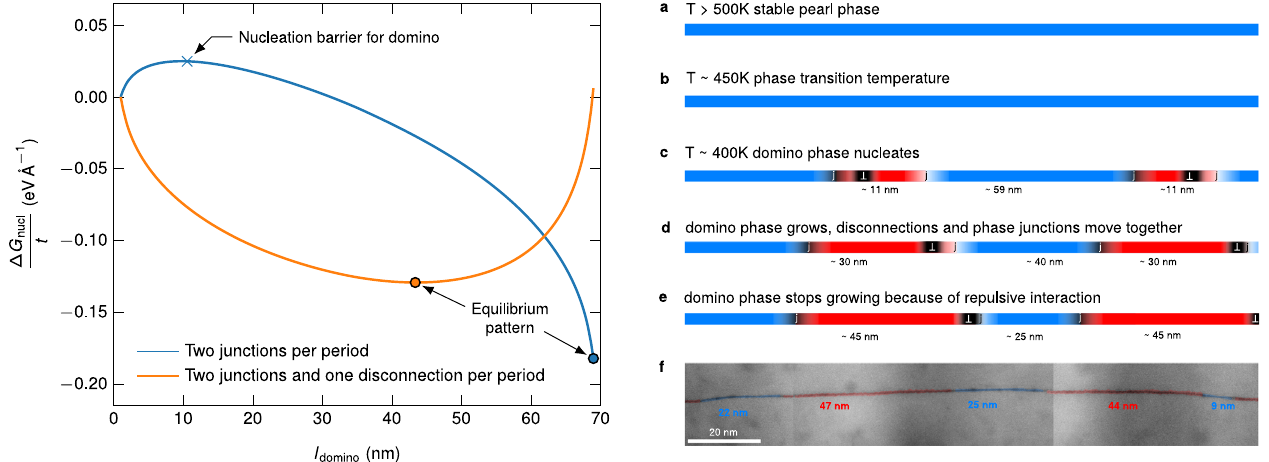
Fig. 8 Free energy change due to a domino nucleus at T = 400K. Calculated for a periodic system of alternating pearl and domino phases with a period L ¼ 70nm. Calculations for a system with only phase junction defects and for a system with an additional disconnection per period. We assume δ 0 ¼ 1nm and subtract the value of Δ G = t at l domino ¼ 1nm, since the offset of the curves depends on the exact value of the defect core energies.